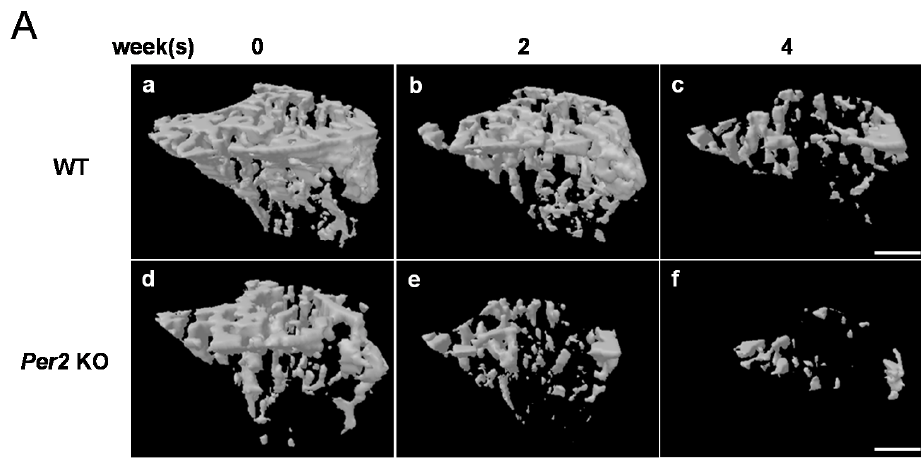
Figure 2. Cont. Figure 2. Cont .